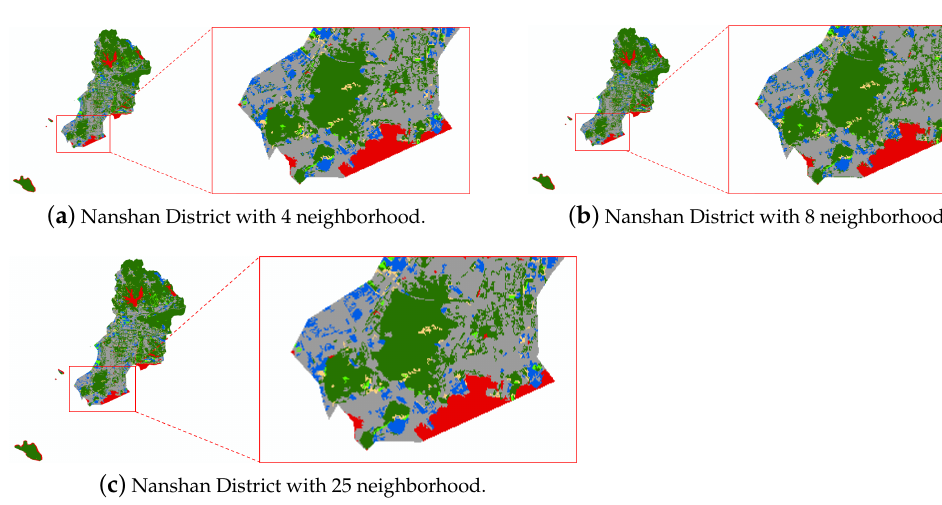
Figure 7. Land-use/land-cover prediction in Nanshan District using different neighborhoods.